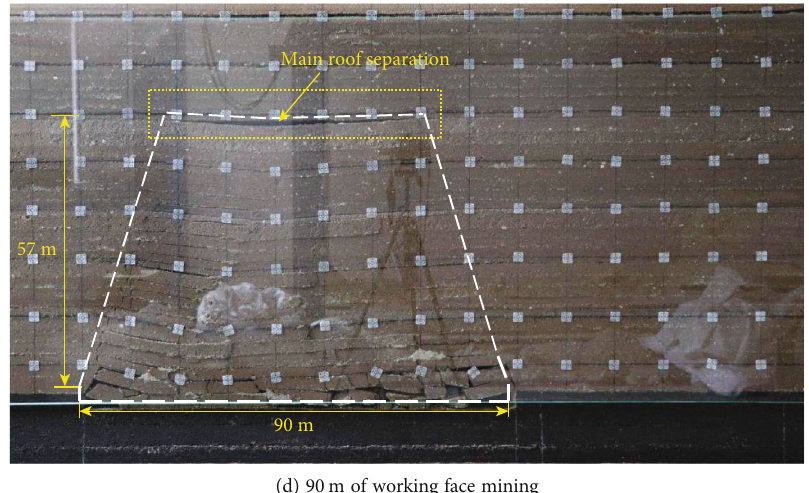
Figure 7: Evolution of overburden structure in a fi rst-layer working face in section